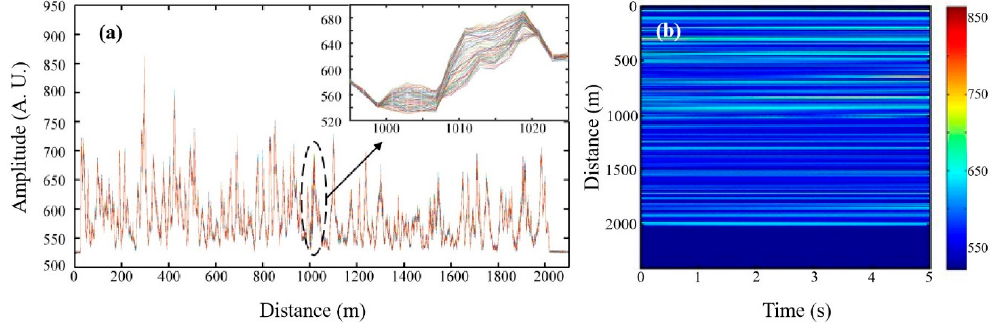
Figure 6. ( a ) The superposition of 100 Rayleigh backwards scattering (RBS) traces, ( b ) two- dimension time – distance RBS figure.